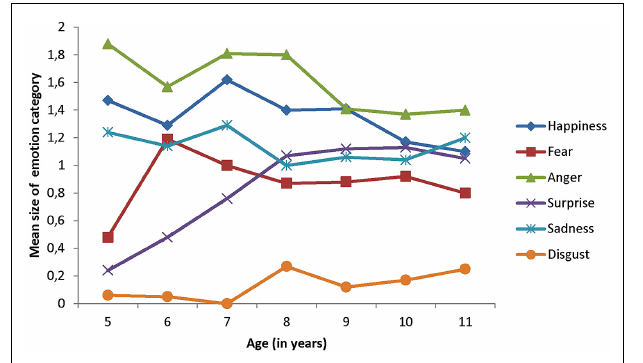
FIGURE 4 | Mean size of emotion categories as of function of age.